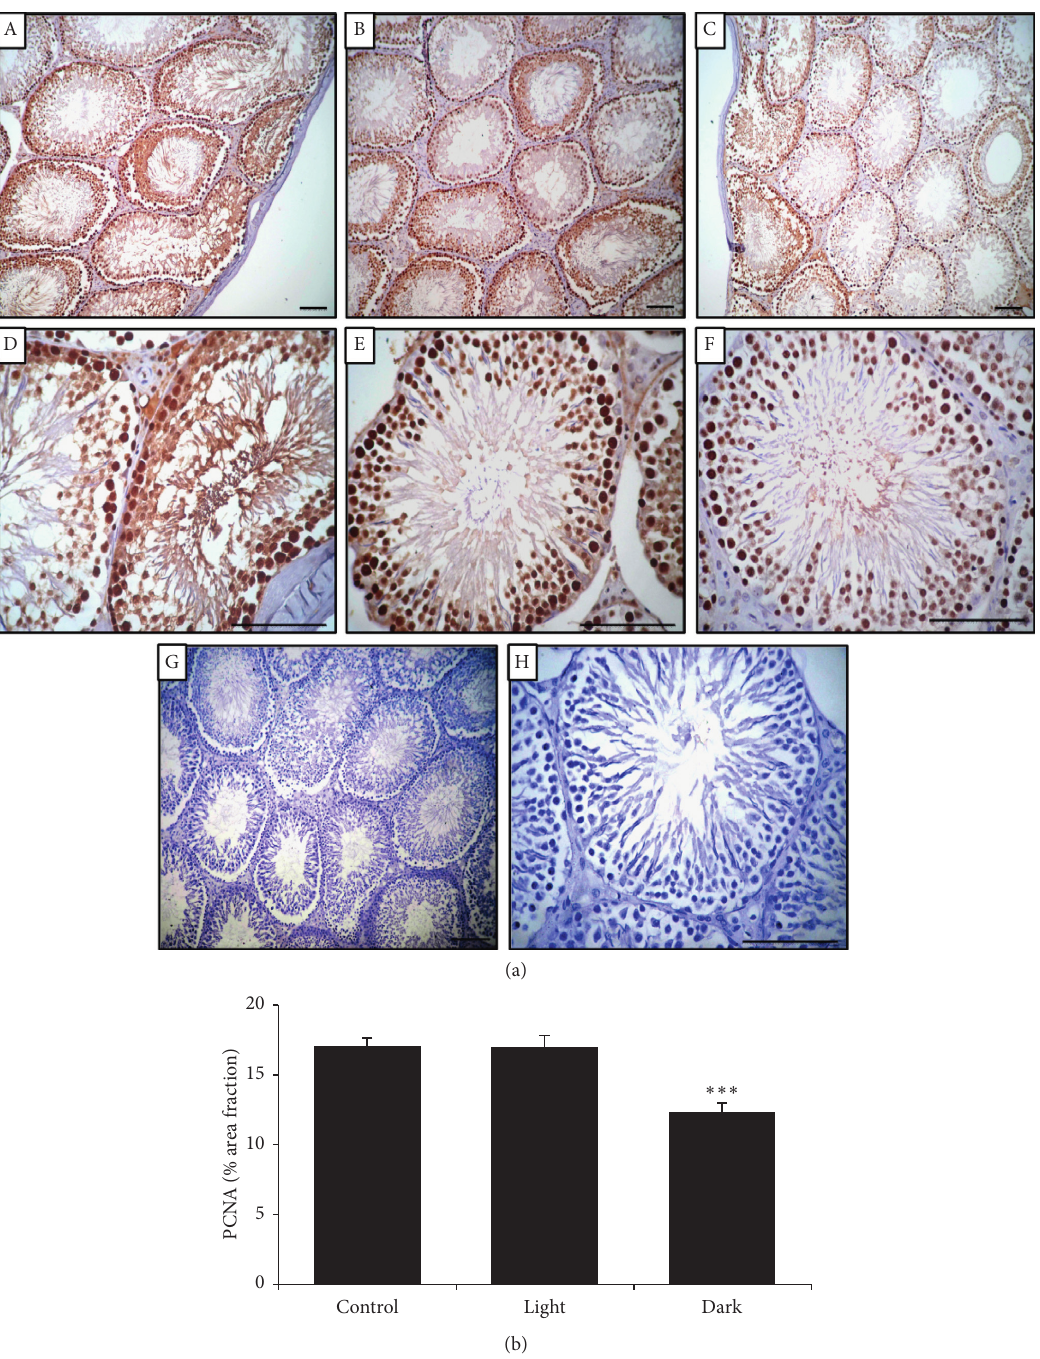
Figure 5: Immunohistochemistry for PCNA localization in rat testes. (a) PCNA immunohistochemistry in testes of (A, D) control, (B, E) prolonged light, (C, F) prolonged dark-exposed groups, and (G, H) negative control. Scale bar � 250 µ m. (b) Percentage of area fraction for PCNA-positive cells. ∗∗∗ P ≤ 0 . 001 vs the control group by Student’s t